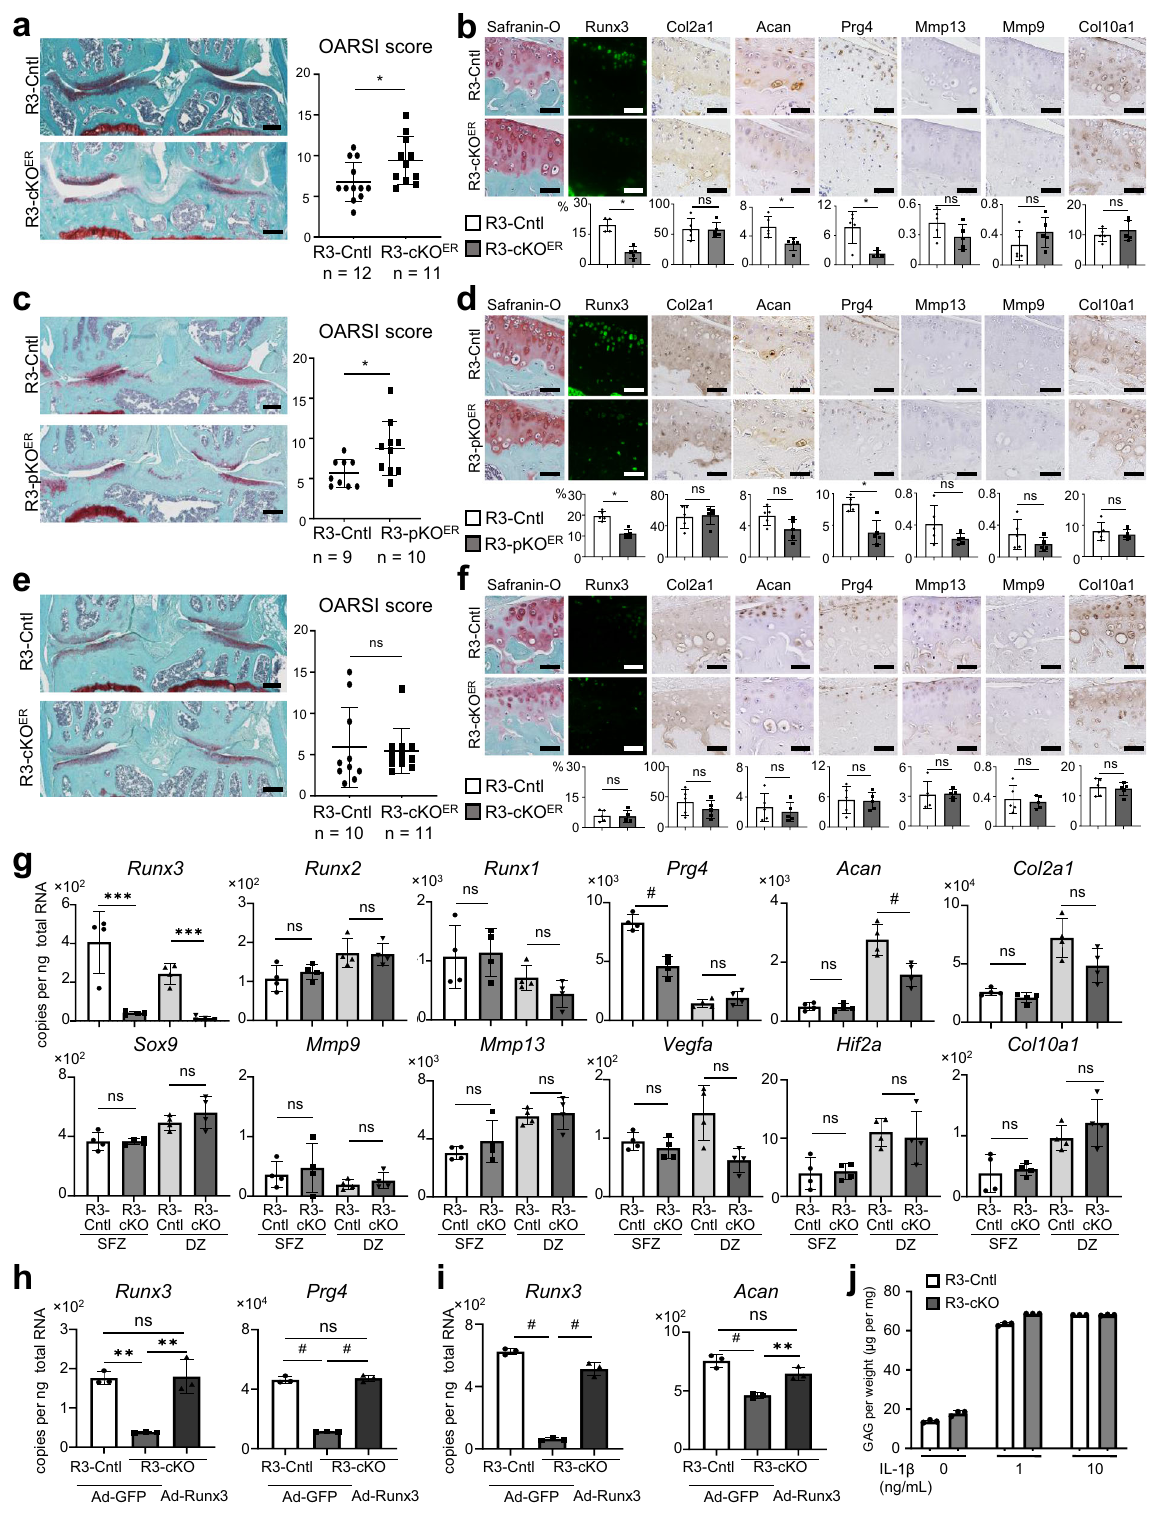
overexpression in Runx3-knockout cells using adenoviral transduc- tion. Downregulation of Prg4 in R3-cKO SFZ cells and Acan in R3-cKO DZ cells was recovered to control levels by Runx3 overexpression (Fig. 2h, i). Additionally, we performed dimethylmethylene blue (DMMB) assays 50 to investigate the catabolic effect of Runx3. Runx3 knockout did not signi fi cantly change the released glycosaminoglycan (GAG) content (Fig.